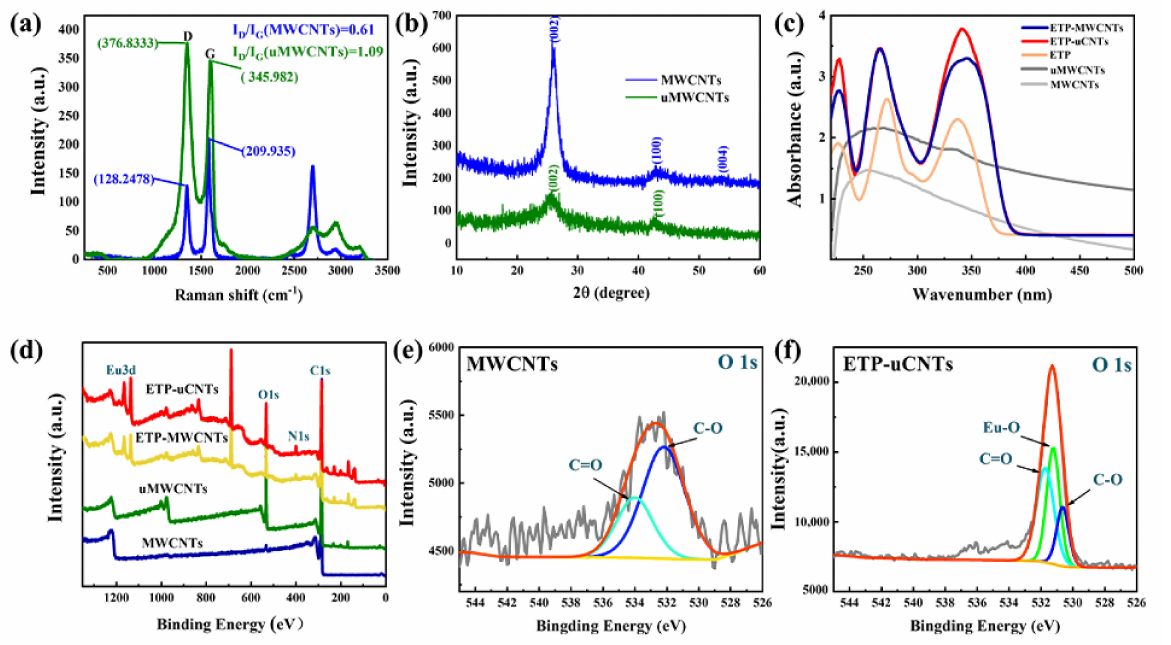
Figure 2. ( a ) Raman spectra of MWCNTs and uMWCNTs. ( b ) X-ray diffraction pattern of MWCNTs and uMWCNTs. ( c ) UV-Vis spectra of MWCNTs, uMWCNTs, Eu complex (ETP), ETP-MWCNTs and ETP-uCNTs. ( d ) XPS total spectrum of MWCNTs, uMWCNTs, ETP-MWCNTs and ETP-uCNTs. XPS fine spectra of O 1s of the ( e ) MWCNTs, ( f )